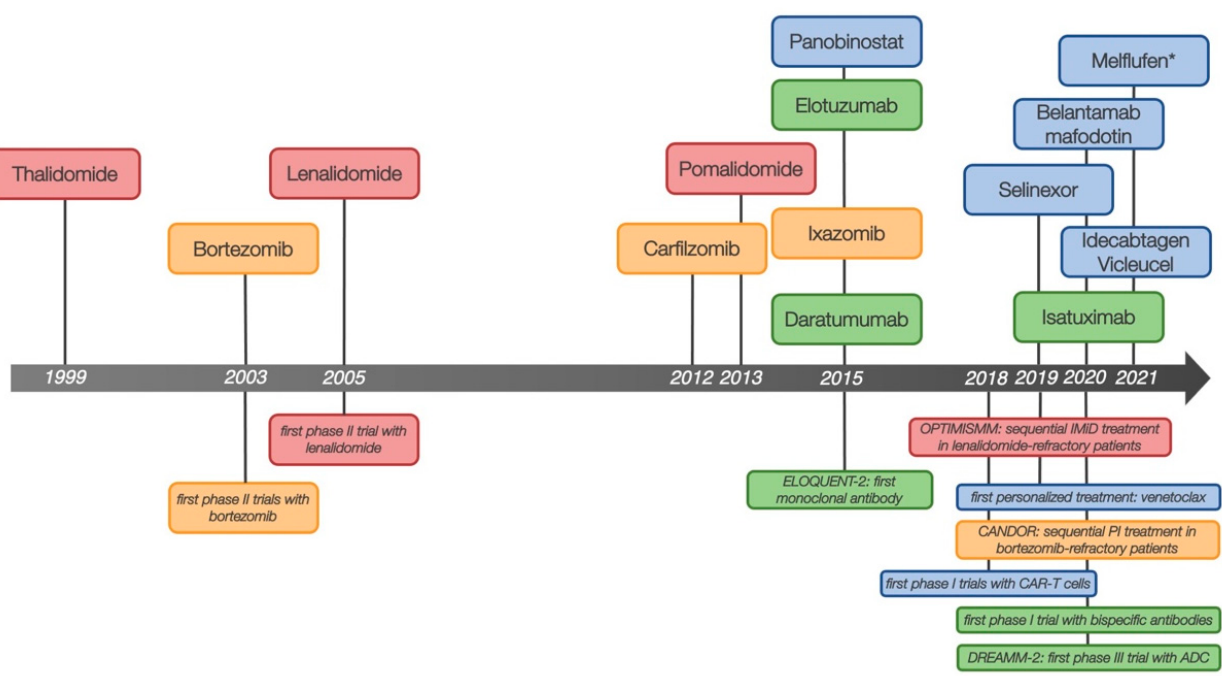
Figure 1. Overview of milestone trials and new agents in RRMM with year of FDA approval. Red: immunomodulators, yellow: proteasome inhibitors, green: monoclonal antibodies, blue: others substance classes; ADC—antibody drug conjugate). * As of October 2021, melflufen has been withdrawn from the US market.